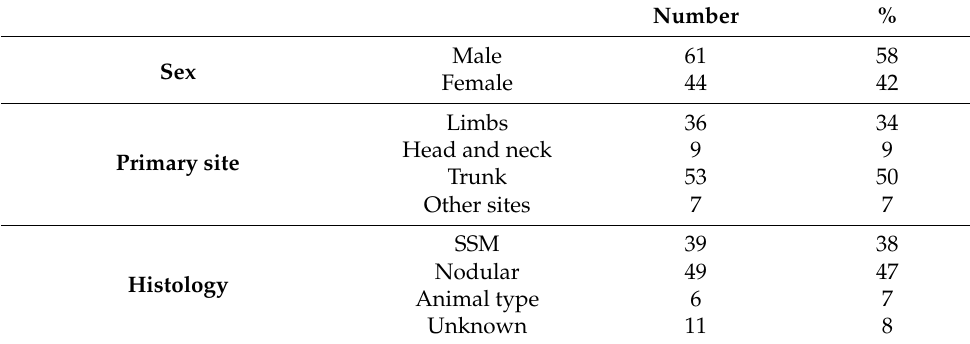
Table 1. Patients’